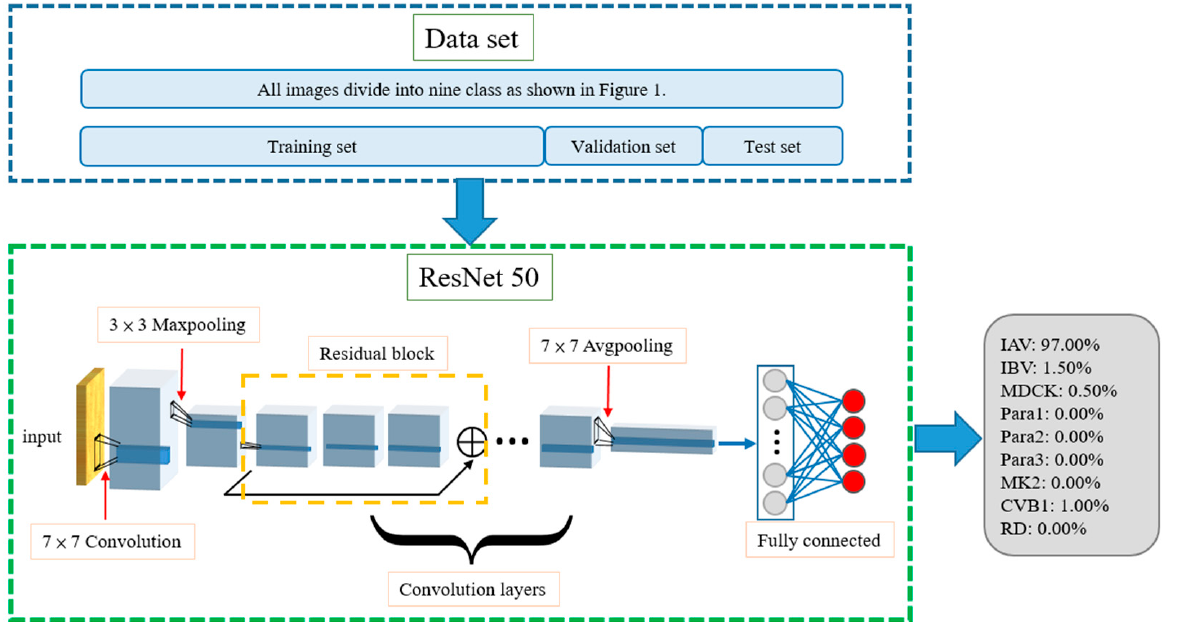
Figure 2. Architecture of single model. Totals of 60%, 20%, and 20% of the data in the dataset were used as the training, validation, and testing sets, respectively. MDCK–IAV is used as an example. The model evaluates the input image’s percentage of each category, and, as an example, we can see that the possibility of MDCK–IAV is 97%. Then the model will classify the input image as MDCK–